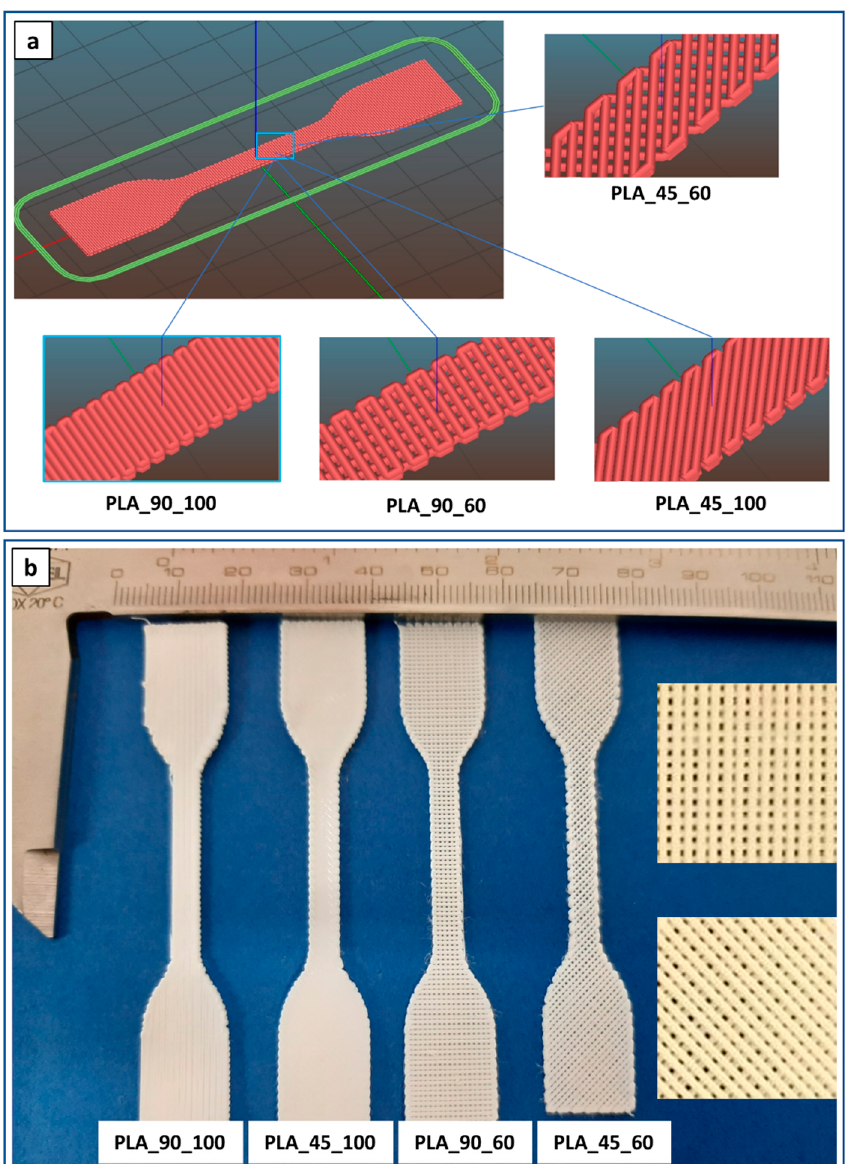
Figure 5. Dog-bone-shaped PLA samples: ( a ) lay-down digital models and ( b ) representative pictures (insets are high magnification details of 60% infill density specimens) of samples with different infill angles and density.